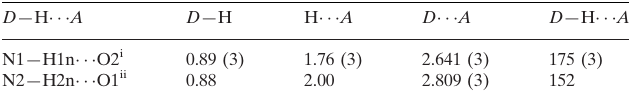
Hydrogen-bond geometry (A˚ , (cid:4)